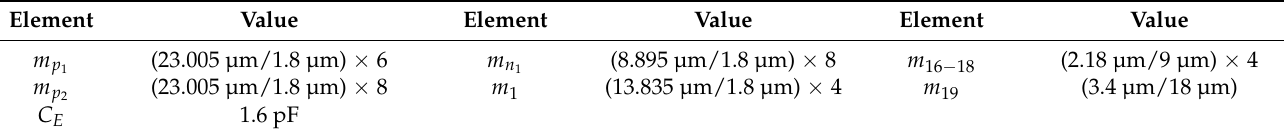
Table 3. Elements and transistor sizes of the voltage